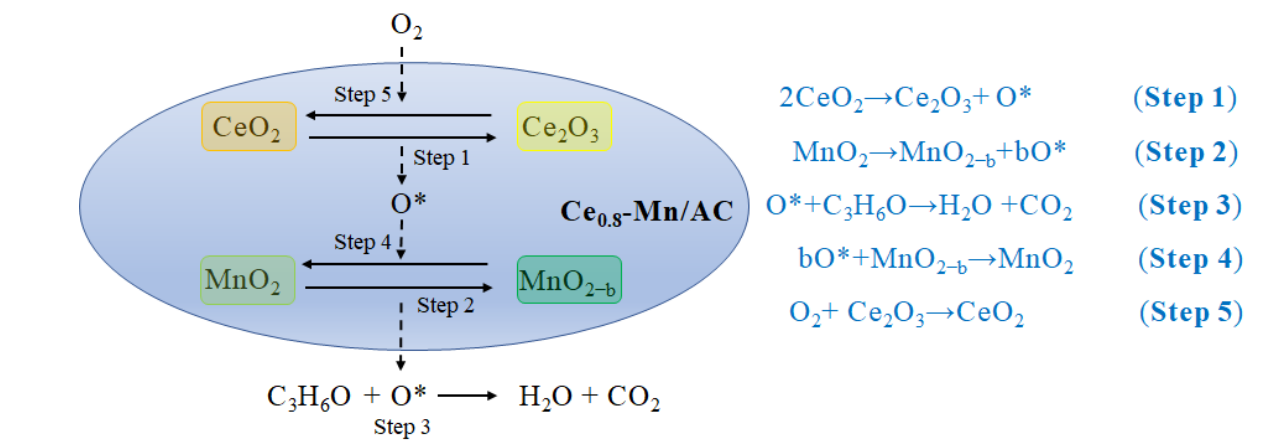
Figure 7. Schematic of catalysts of the acetone on Ce 0.8 -Mn/AC.